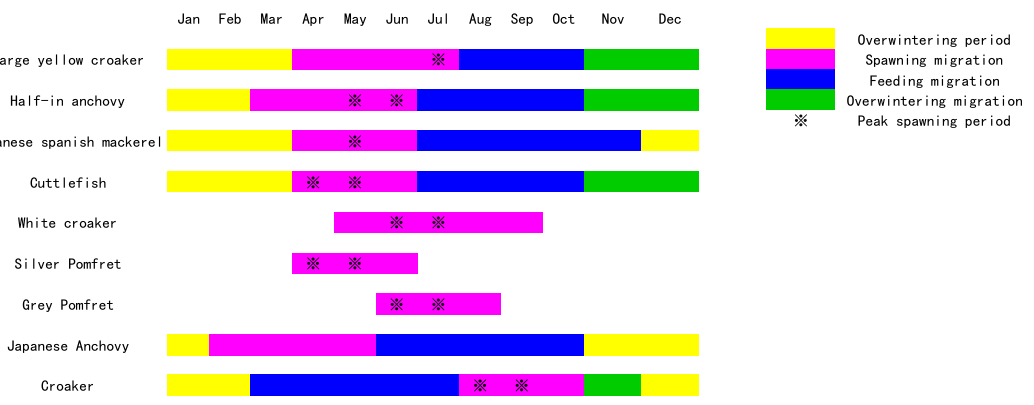
Figure 6. ( a – i ) The spawning grounds and feeding grounds of nine main fish species, including Large yellow croaker, half-in anchovy, Japanese Spanish mackerel, cuttlefish, white croaker, silvery pomfret, grey pomfret, Japanese anchovy and croaker. Red circle: The spawning ground. Dotted line: The feeding ground. Arrows: The direction of spawning migration.